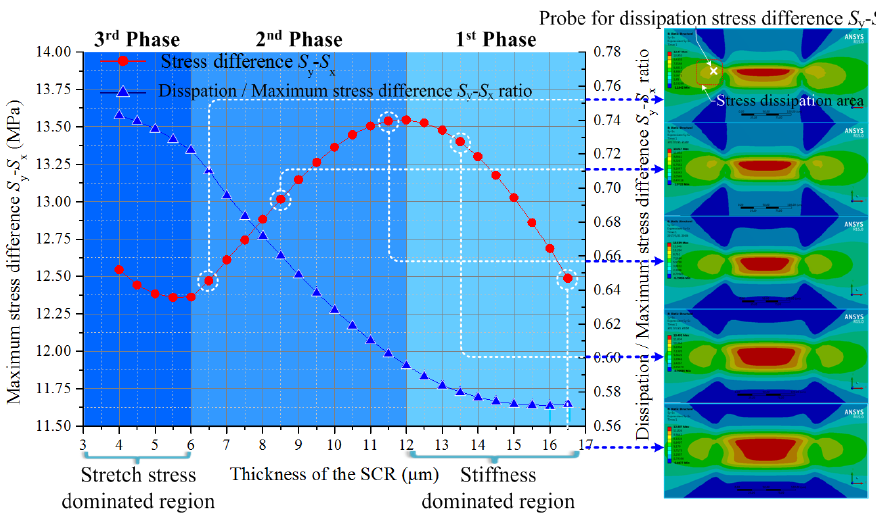
Figure 5. Stress concentration condition around the SCR influenced by the stiffness difference variation along the transversal direction.